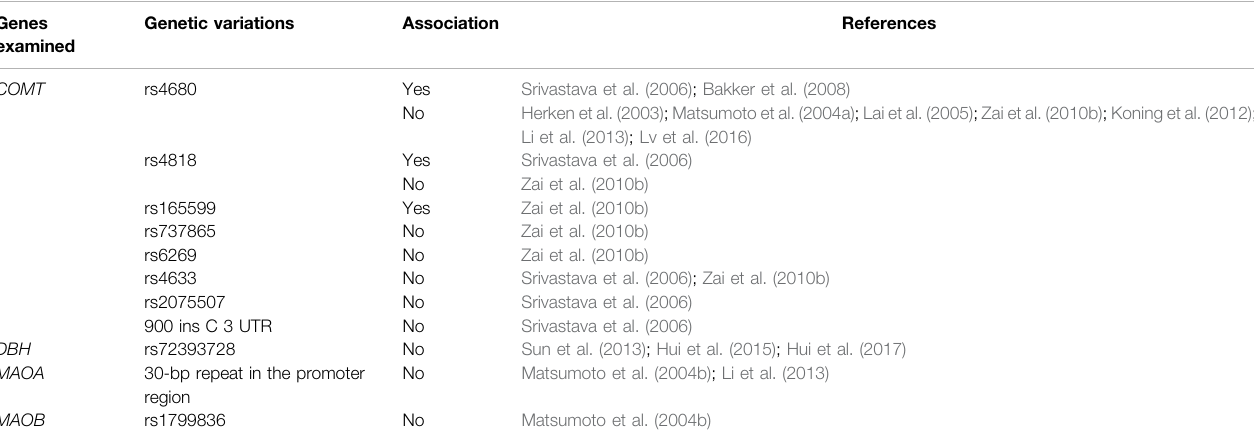
TABLE 6 | Genetic variability of neurotransmitter biosynthesis and degradation pathways and its association with TD. Genes